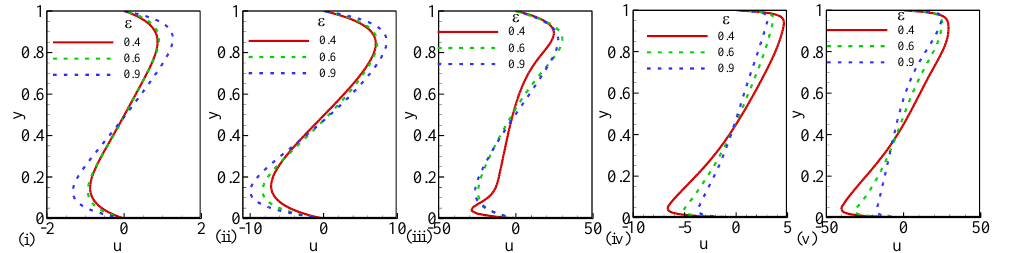
Fig. 6 (b). Effect of porosity parameters on normalized u velocity of vertical porous layer at (i) Ra =10 3 , = 10 −2 , (ii) Ra =10 4 , Da =10 -2 . (iii) Ra =10 5 , Da =10 -2 , (iv) Ra =10 5 , Da =10 -4 and (v) Ra =10 6 , Da =10 -4 .